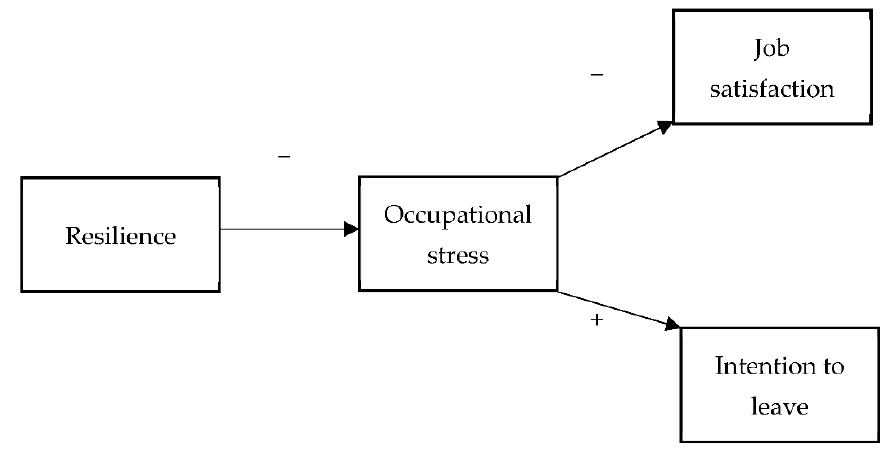
Figure 1. Model tested.